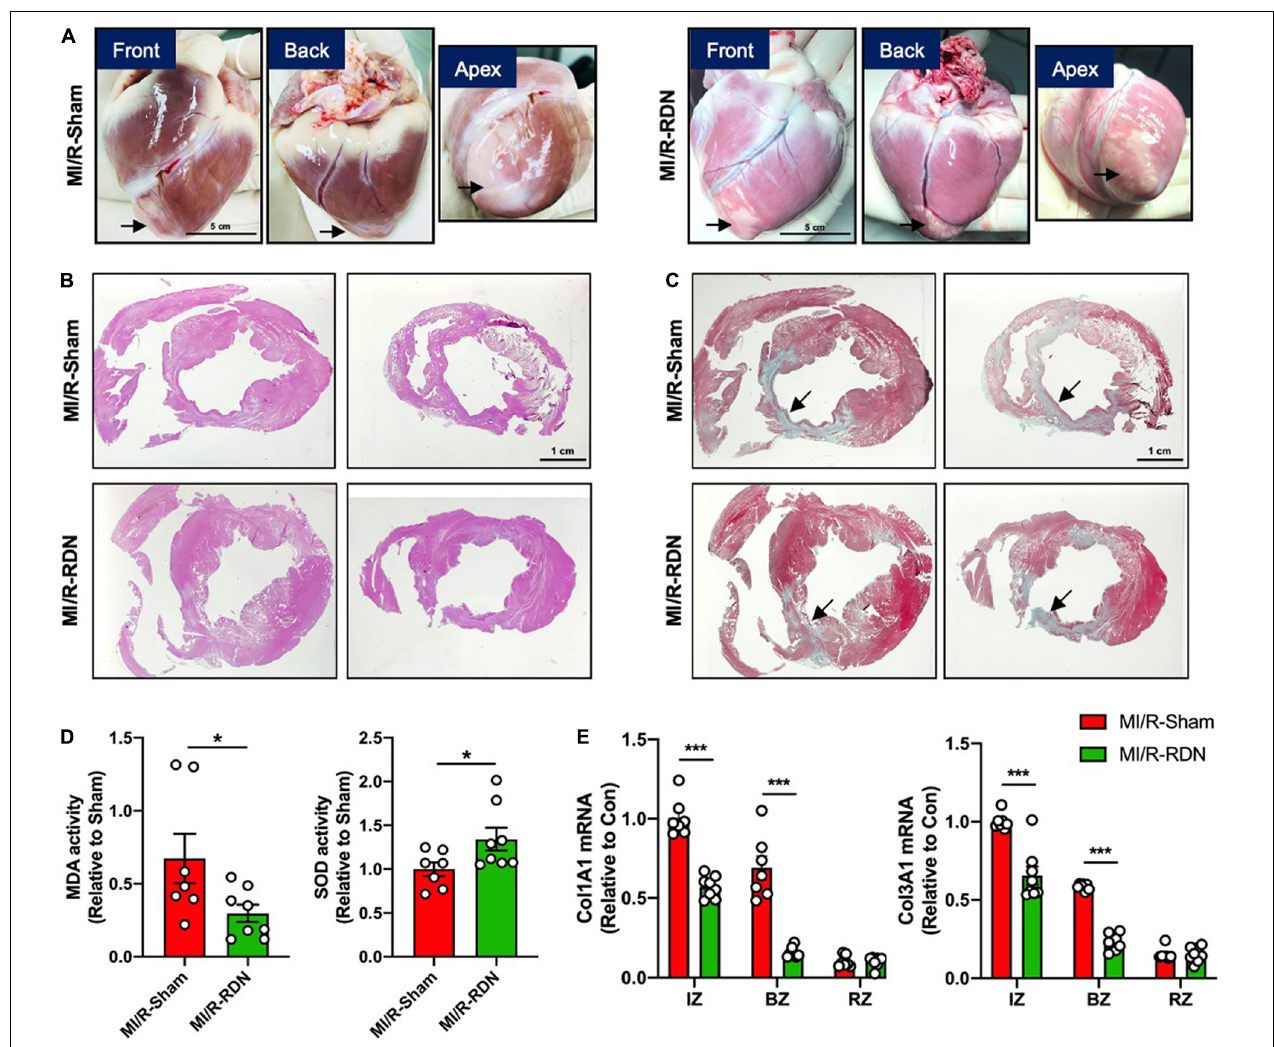
FIGURE 5 | Histological analysis and collagens expression levels. (A) Minipig heart tissue was taken from the front, back, and apex. (B) Representative photomicrographs of HE-stained heart sections from the MI/R-sham- and MI/R-RDN-treated animals. (C) Representative photomicrographs of Masson’s trichrome-stained heart sections from the MI/R-sham- and MI/R-RDN-treated animals. (D) Activity of the malondialdehyde (MDA) and the antioxidant enzyme superoxide dismutase (SOD) in the border zone of LV were detected. The data are shown as the fold change relative to the MI/R-Sham group. (E) Fibrotic gene profile consisting of the mRNA expression of collagen 1 (Col1A1) and collagen 3 (Col3A1). The expression of these genes was normalized to GAPDH expression and is shown as the fold change relative to the IZ in the MI/R-Sham group. n = 7 in the IM/R-Sham group, n = 8 in the IM/R-RDN group. Data are shown as the mean ± SEM (D,E) . p -Values were shown and assessed by unpaired, two-tailed t -test (D) and two-way ANOVA with Bonferroni test (E) . * p < 0.05, *** p < 0.001 (compared with the MI/R-Sham